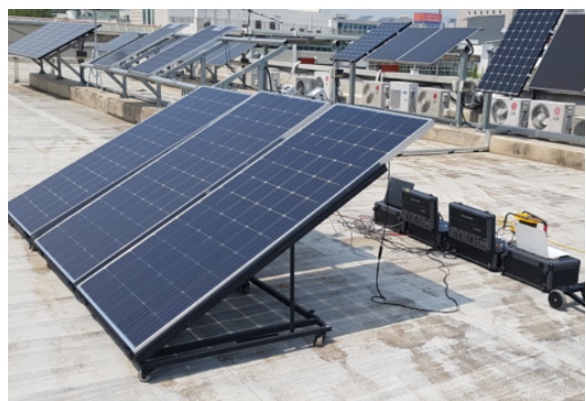
Figure 8. PV Power Platform with IoT sensors in Konkuk